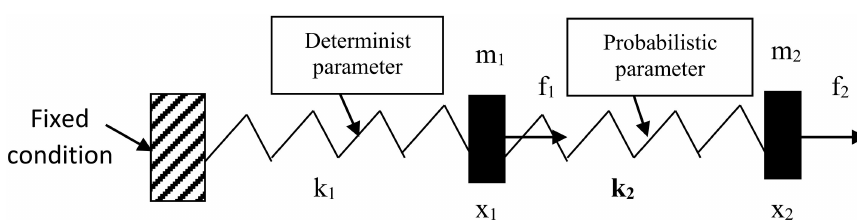
Figure 17. Mass-spring system with two degrees of freedom. k 1 = 1E11 N/m is a deterministic parameter, and k 2 is a probabilistic one defined by: Figure 18a,b show, respectively, the evolution of the displacement x 1 and x 2 according to the functions of the circular natural frequency ω and that for different values of P 2 = 0.25, P 2 = 0.5, and P 2 =